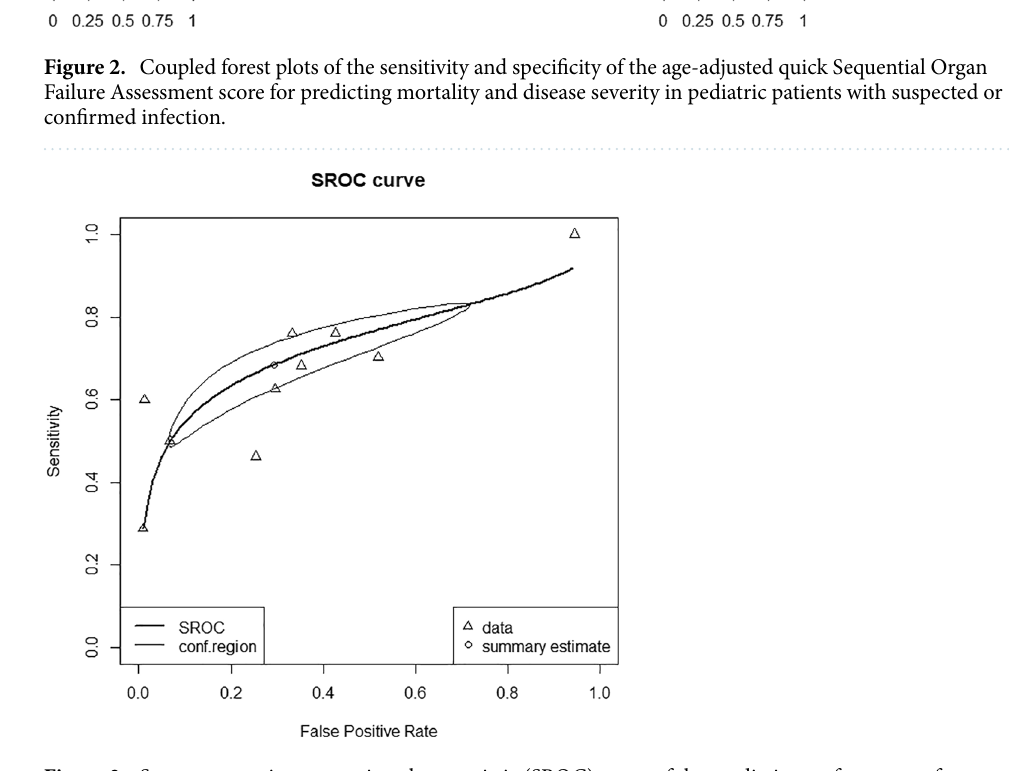
Figure 3. Summary receiver-operating characteristic (SROC) curve of the predictive performance of age- adjusted quick Sequential Organ Failure Assessment score for mortality and disease severity in pediatric patients with suspected or confirmed infection. The area under the curve of the SROC was 0.733 (95% CI 0.683–0.768). conf.region, 95% confidence region for SROC